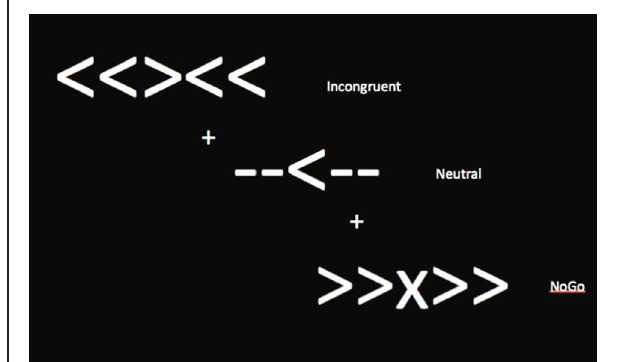
FIGURE 1 | Sample stimuli for the fMRI task of cognitive